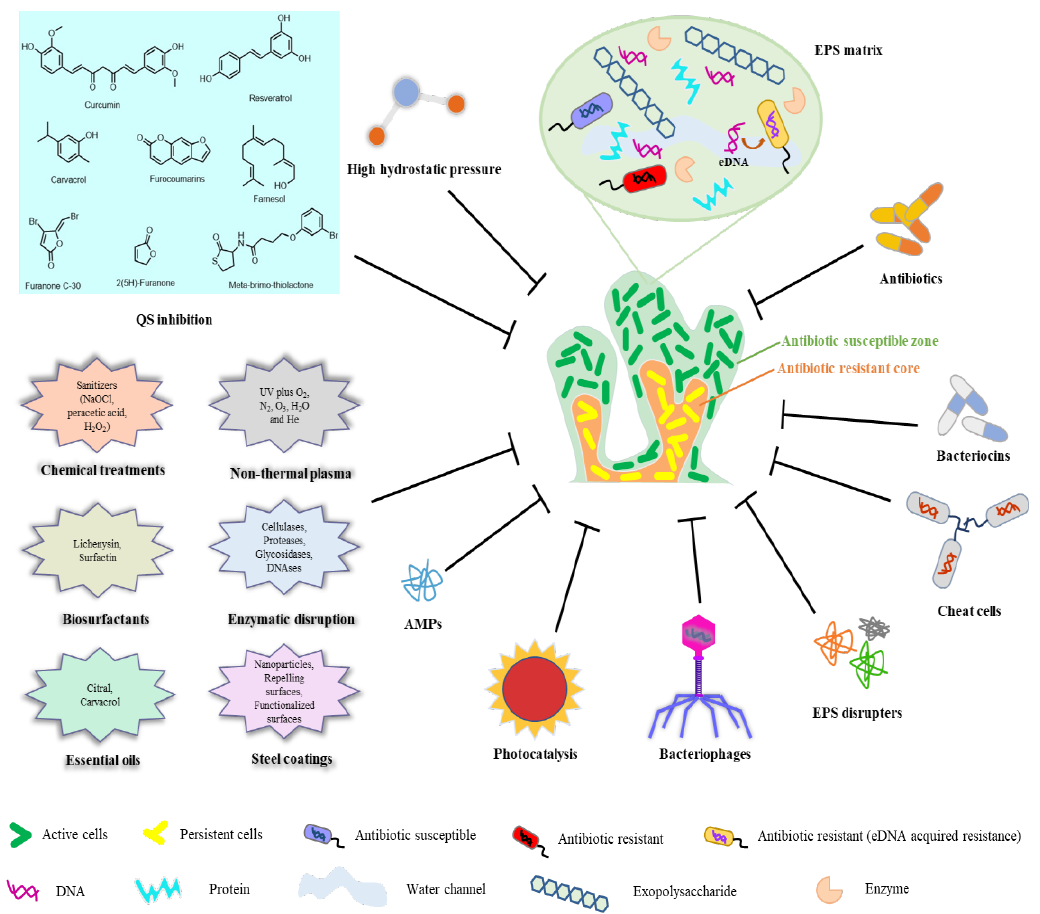
Figure 3. Biofilm control methods and their uses in the food